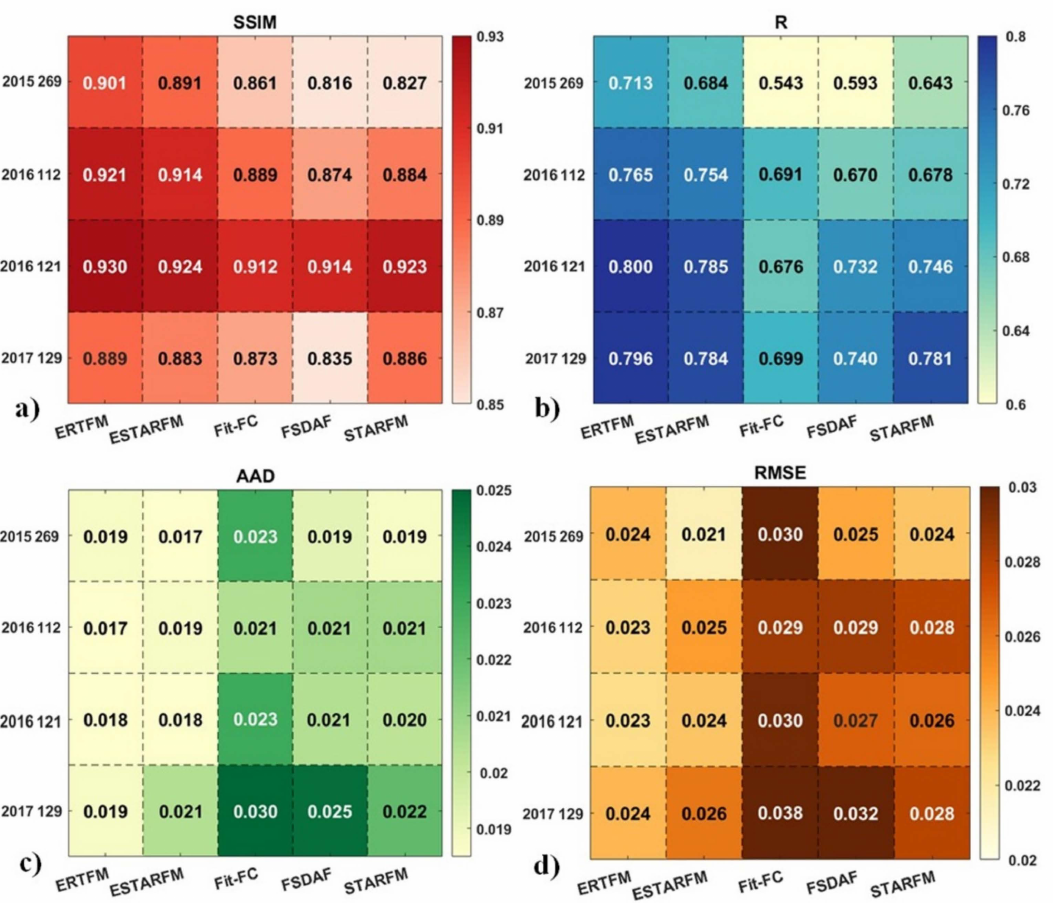
Figure 8. Comparison of the ERTFM with the other four spatiotemporal fusion models, STARFM, ESTARFM, FSDAF,